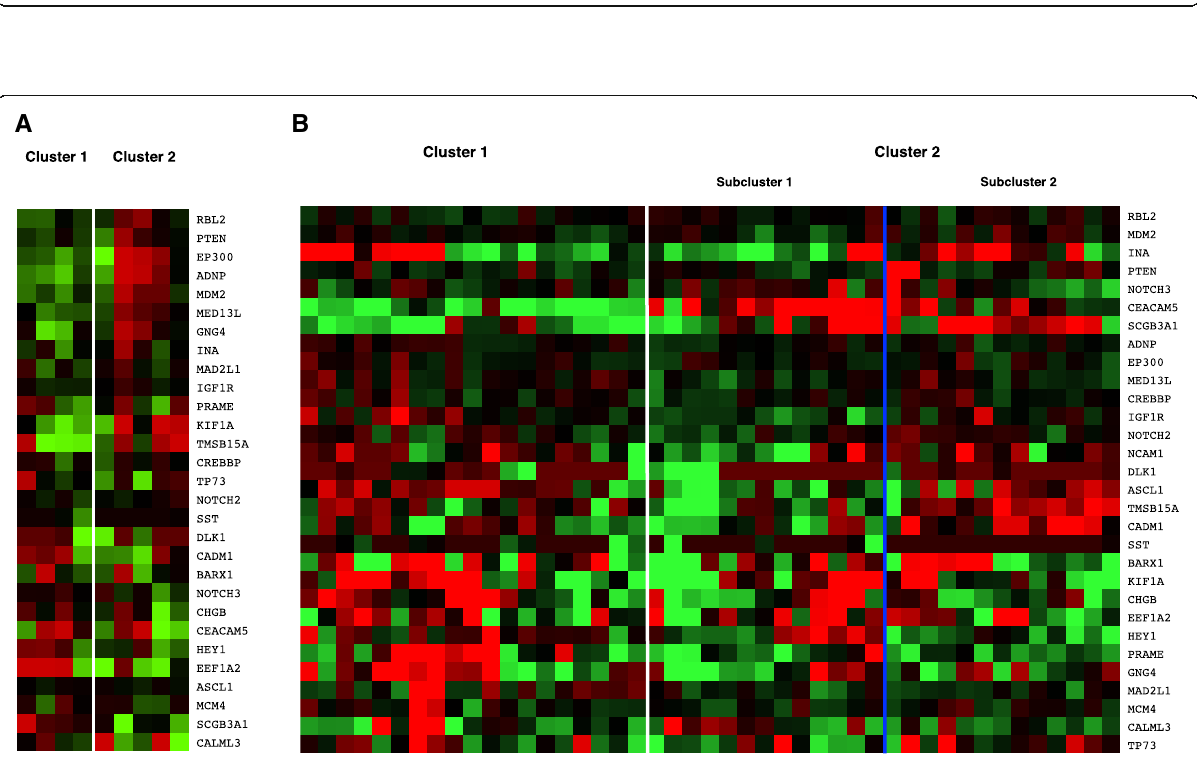
Fig. 3 Hierarchical clustering using differentially expressed genes. Red indicates decreased expression, while green indicates heightened expression. A Hierarchical clustering of unpaired basaloid squamous cell carcinoma samples distinguishes tumors based on immunohistochemical NE status. Cluster 1 is enriched for NE negative (by IHC) samples (0/4), while Cluster 2 is enriched in NE positive tumors (4/5) ( p = 0.048). B Hierarchical clustering of TCGA samples distinguished cases based on tumor type. Cluster 1 is enriched with non-basaloid squamous cell carcinomas (2/19 are basaloid type), while Cluster 2 is enriched with basaloid squamous cell carcinomas (13/26 are basaloid type) ( p = 0.0094). A subset of cases from Cluster 2 (Sub-cluster 1) demonstrate higher expression of NOTCH pathway genes including DLK1 (log 2 FC = 2.8), ASCL1 (log 2 FC = 1.8), CHGB (log 2 FC = 1.0) and NCAM1 (log 2 FC =